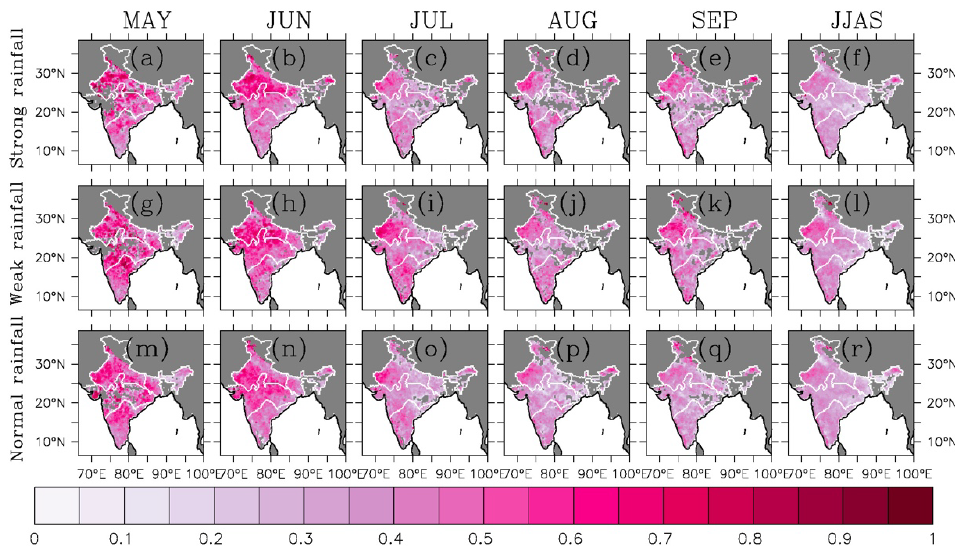
Figure 6. Spatial distribution of correlation coefficient between daily SM and daily rainfall in India for May through September and JJAS during strong ISMs ( top row , ( a – f )), weak ISMs ( second row , ( g – l )), and normal ISMs ( bottom row , ( m – r )). The correlation was computed based on soil moisture grids using the IMD 0.25 ◦ grids daily rainfall and 0.25 ◦ grids daily SM. The correlation coefficient is shown only when it is significant at a 95% confidence level. The borders between the IMD regions are shown in white.